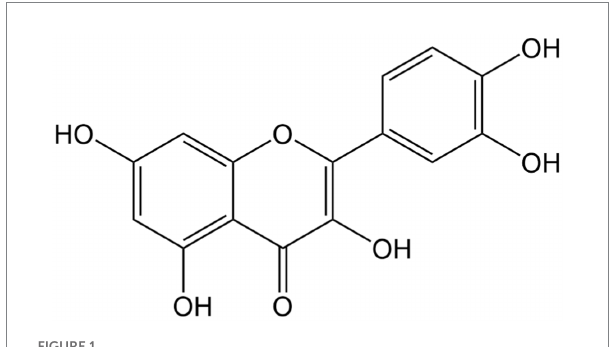
FIGURE 1 Chemical structure of